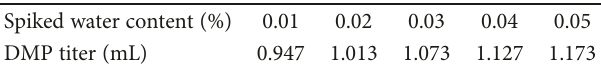
Table 4: Corresponding relationship between spiked water content and DMP titer.